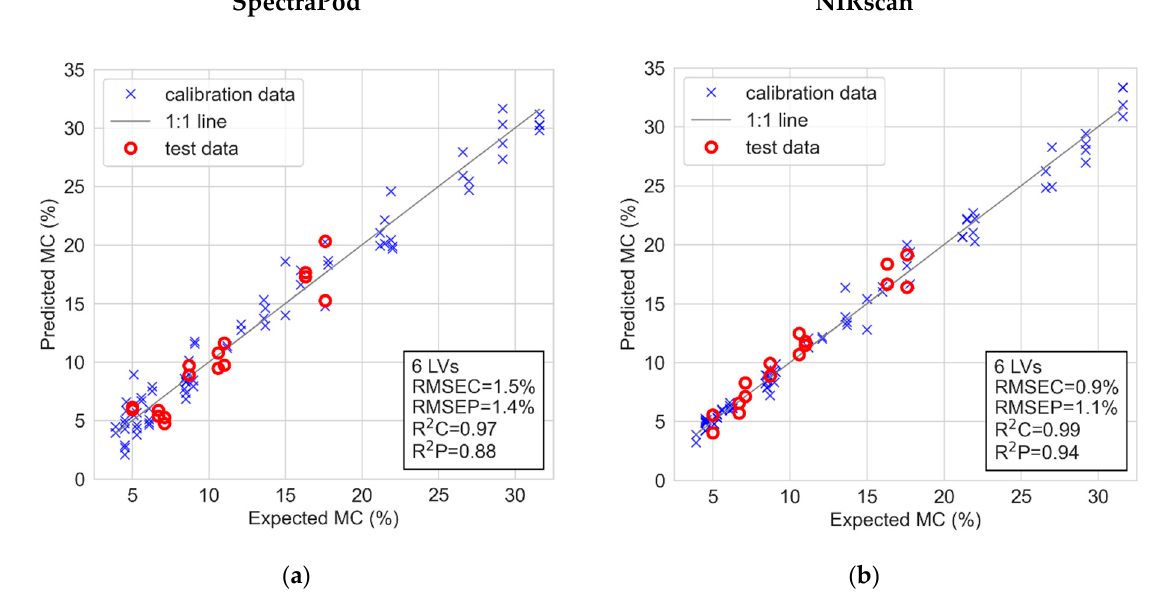
Figure 3. The predicted moisture content of two types of rice grains, obtained via PLS regression using normalized photocurrents from the SpectraPod ( a ) and NIRscan ( b ), compared to their expected values, obtained via the oven-drying method. The number of latent variables (LVs), the root mean square error of calibration (RMSEC) and prediction (RMSEP) and the coefficient of determination for the calibration (R 2 C) and prediction (R 2 P) are indicated.